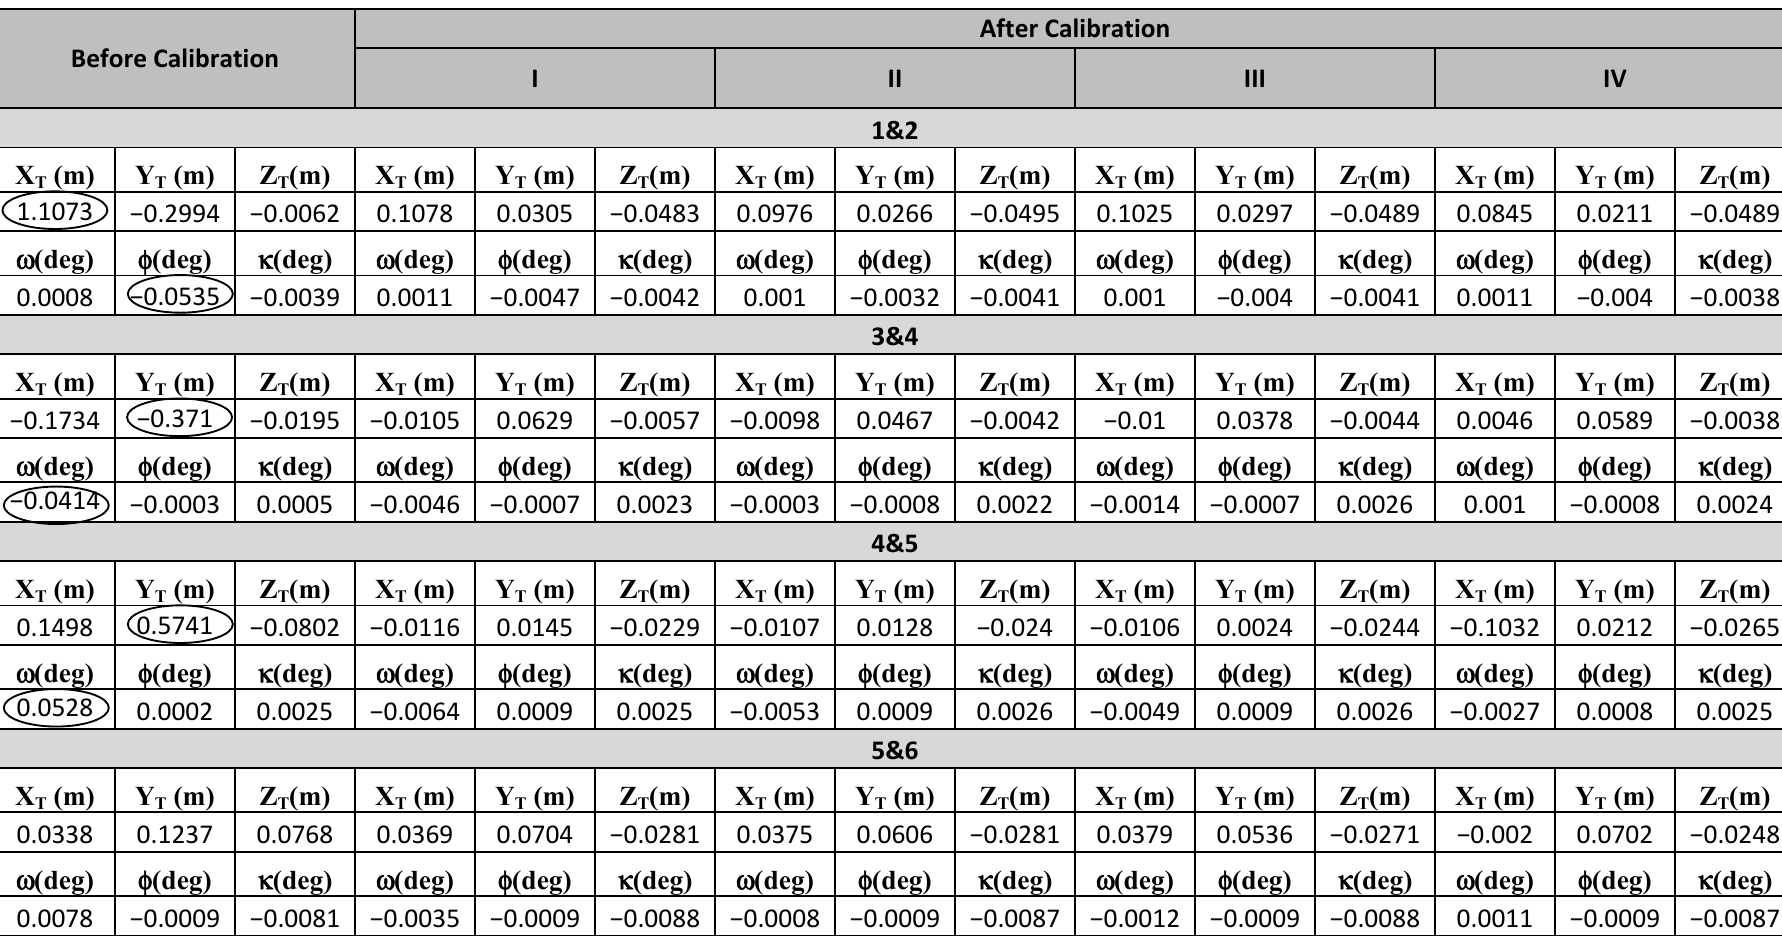
Table 3. Discrepancies between overlapping strips before and after applying the calibration parameters estimated using the different